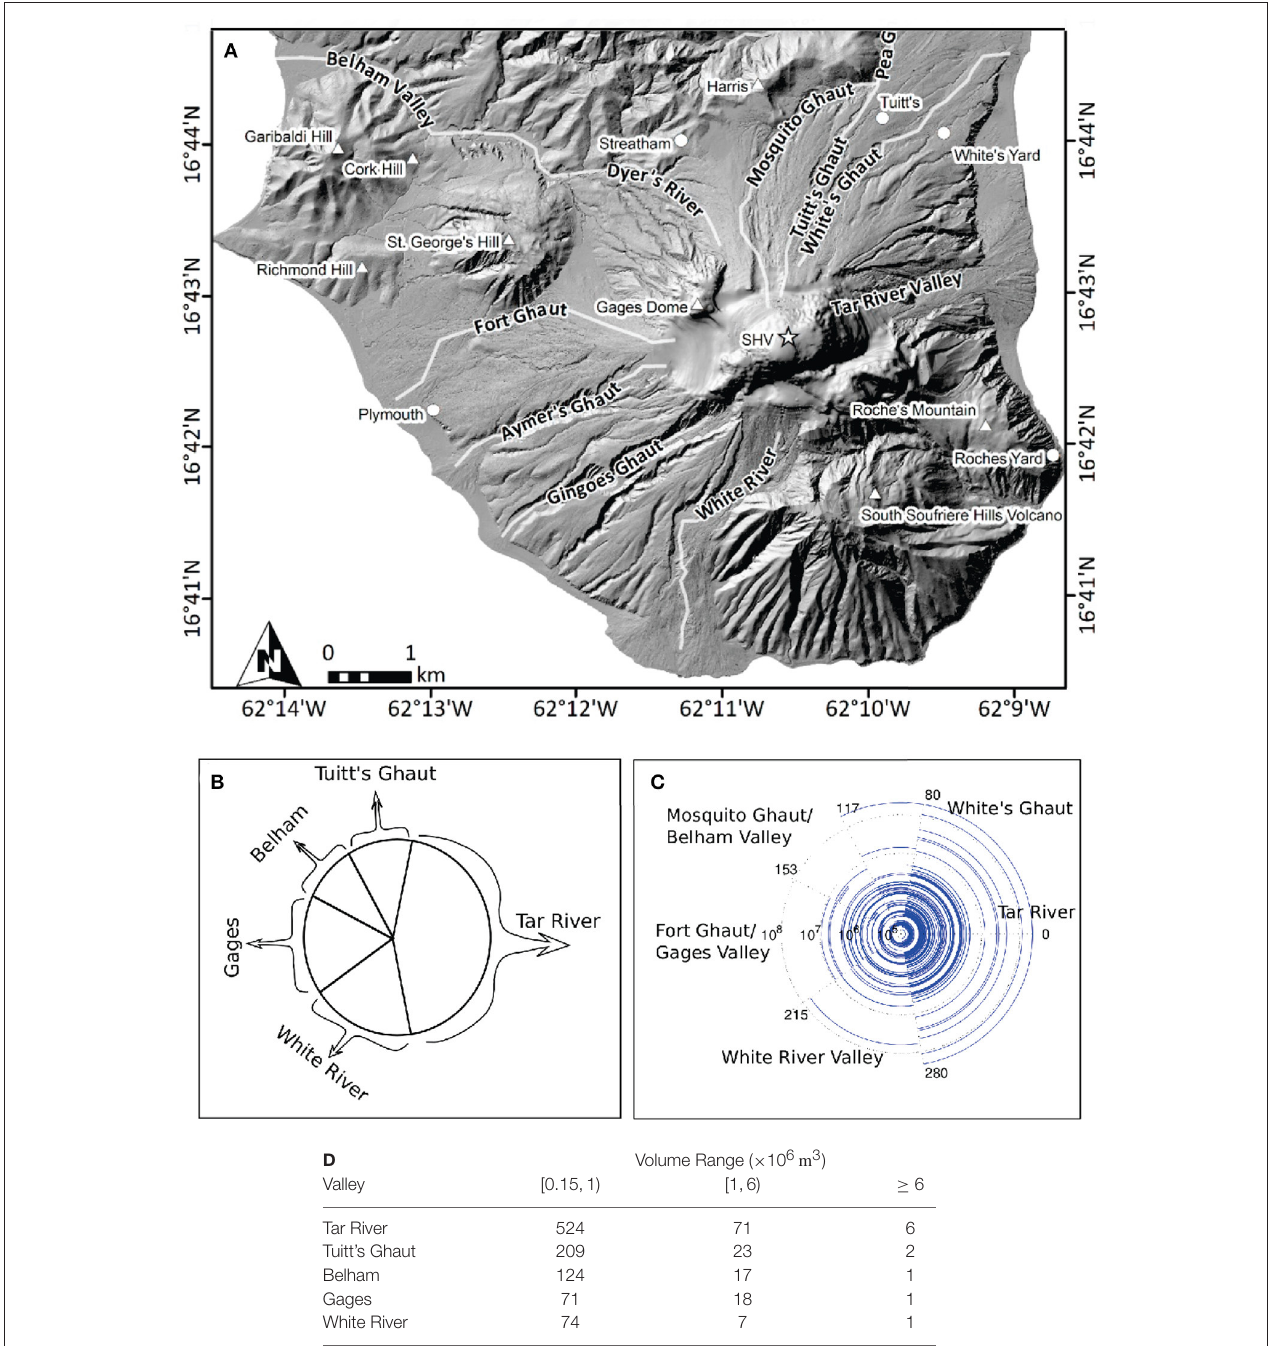
FIGURE 1 | (A) Topographic map of southern Montserrat, showing SHV and valley contours. (B) Cartoon drawing illustrating major drainages (valley groups). (C) Empirical plot of PDC volumes V j (as radius, on log scale) and initial directions φ j (as angles counter-clockwise from due East, in degrees). (D) Tabulated counts of PDCs inundating the five major drainages, for each of three PDC volume